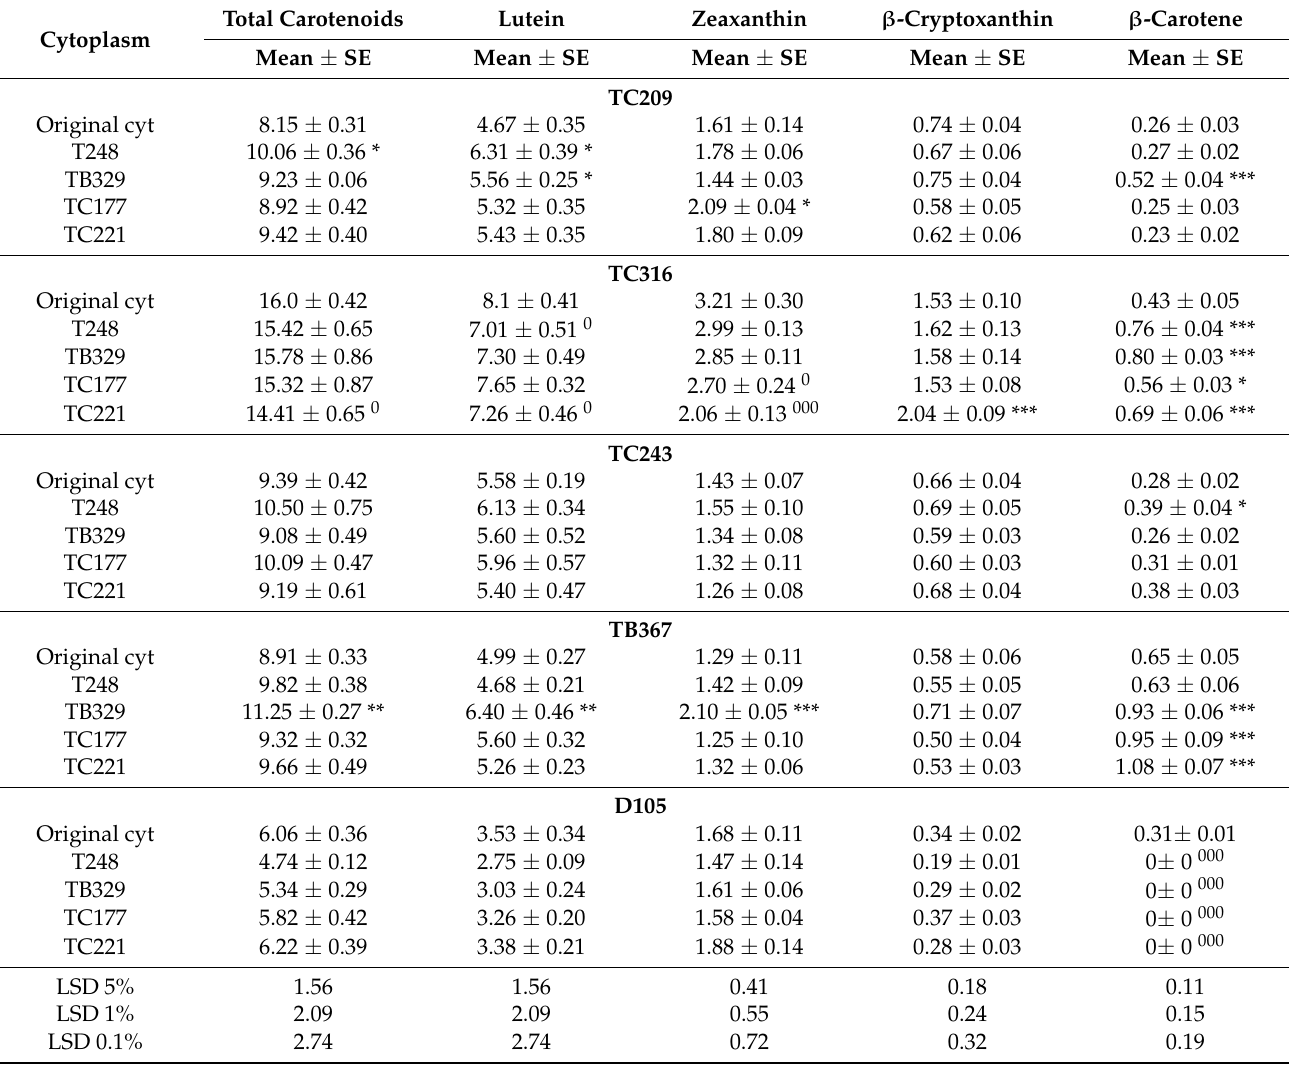
Table 3. The influence of cytoplasm × nucleus interaction on the carotenoid content of the isonuclear lines ( µ g/g)—ANOVA